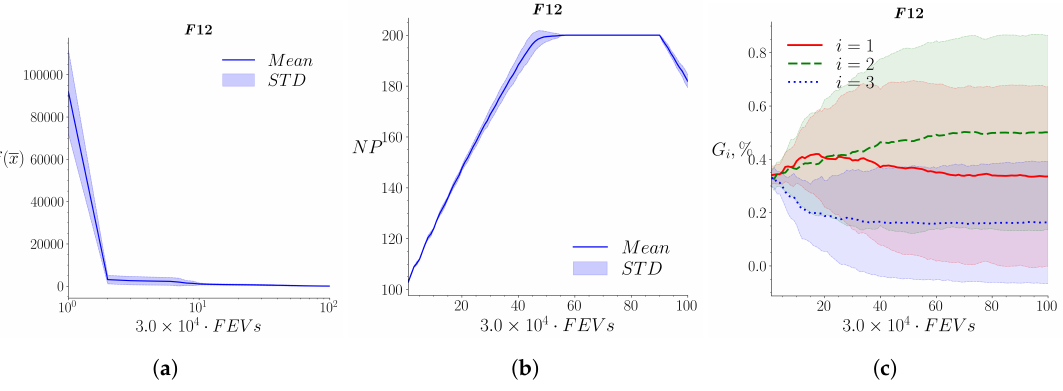
Figure A11. The dynamics of COSACC-LS1 on the F11 problem: ( a ) Convergence; ( b ) Population size; ( c ) Redistribution of resources.